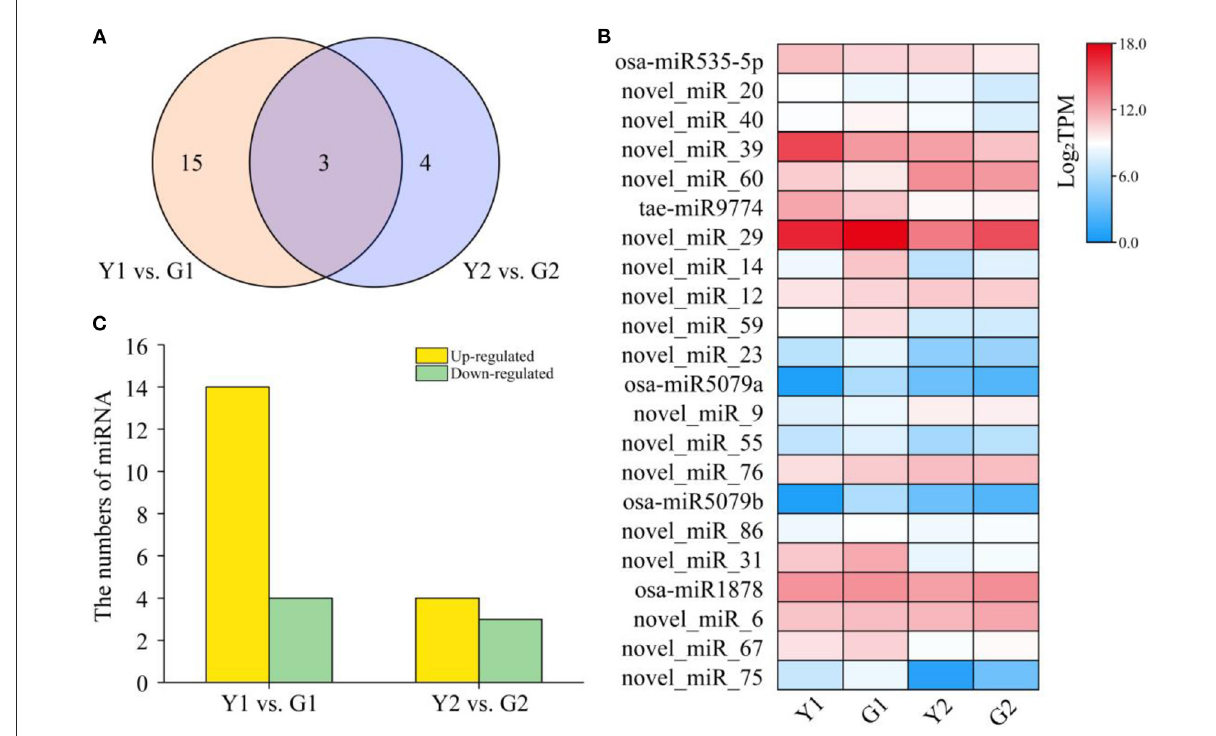
FIGURE7 Different expression analysis of miRNAs in the greening process of P. vivax . (A) Venn diagram of miRNA distribution in two comparisons, respectively. (B) Heatmap of expression of all DEMs in four samples. (C) Specific expression distribution of DEMs in two